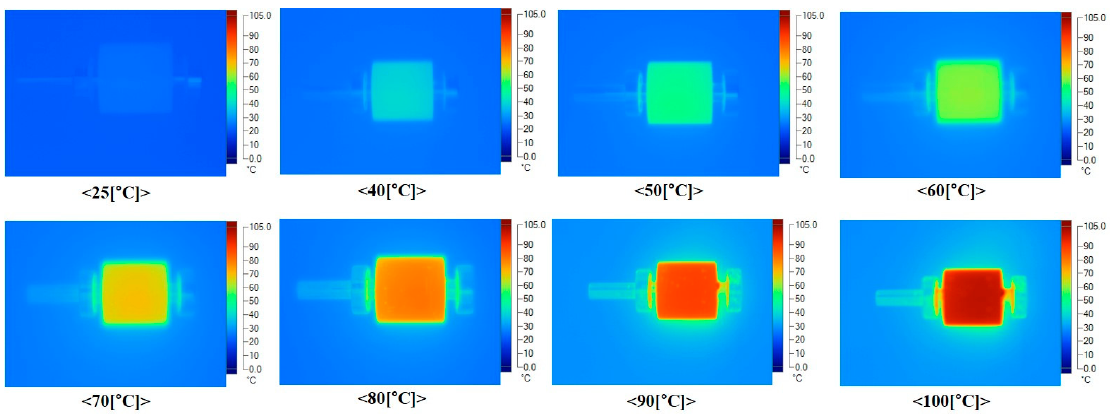
Figure 7. Experimental measurement of PM temperature of the test SPMSM.